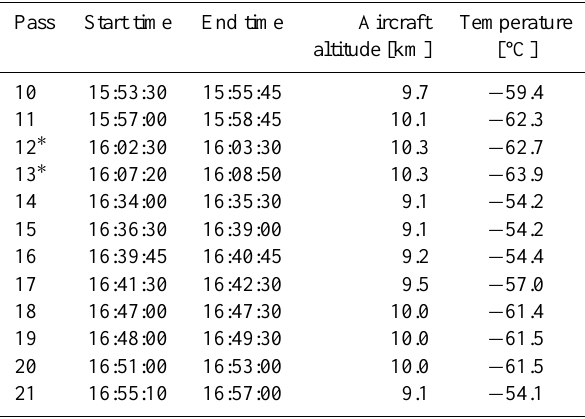
Table 2. “Other” aircraft contrail passes.